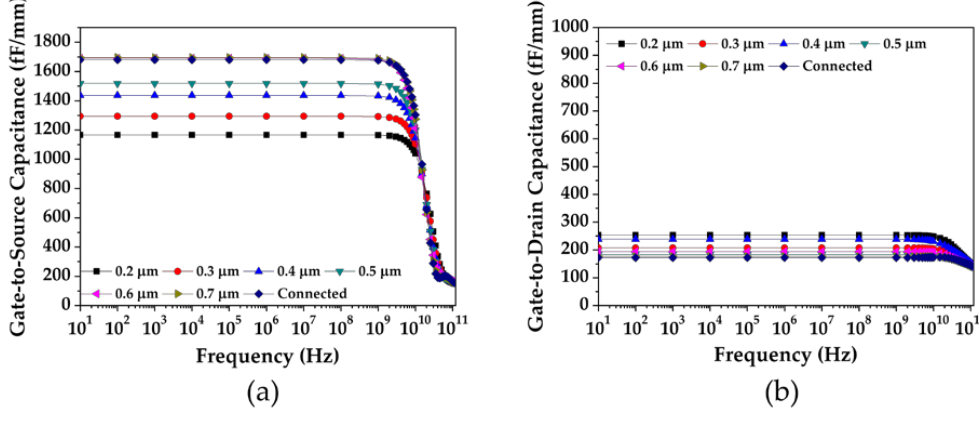
Figure 10. Capacitance variations for different IFP lengths: ( a ) gate-to-source capacitance; ( b ) gate-to-drain capacitance.